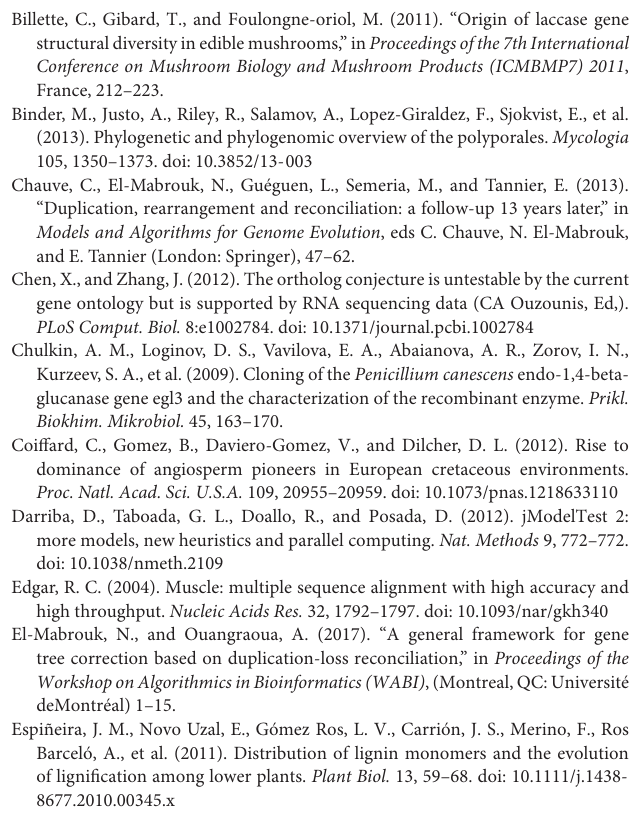
FIGURE S2 | The gene-tree/species-tree reconciliation analysis. For the fungal species abbreviations refer to Figure 1 . TABLE S1 | The laccase sequences used in this study. TABLE S2 | Properties of various laccase isozymes from different